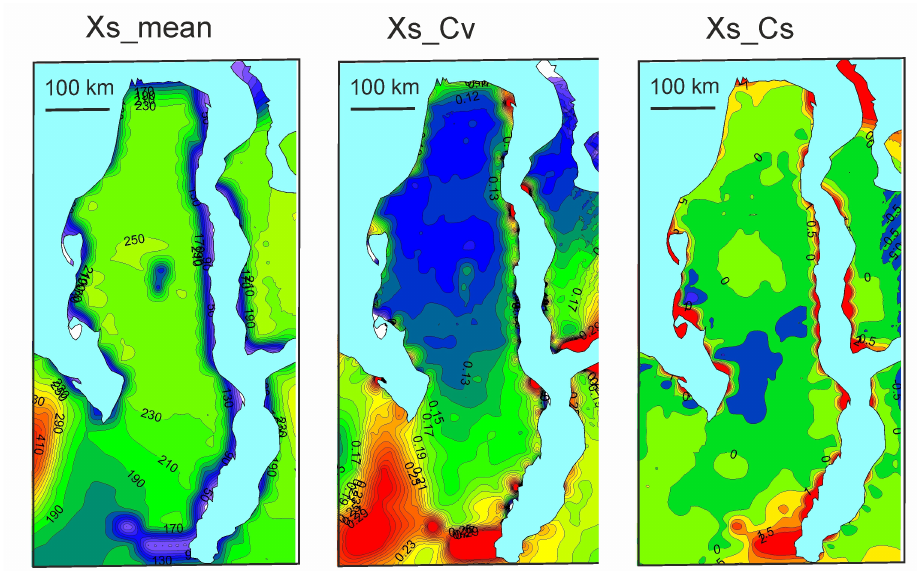
Figure 22. Spatial distributions of mean annual X sa and its temporal variability C v and skewness C s on the Yamal